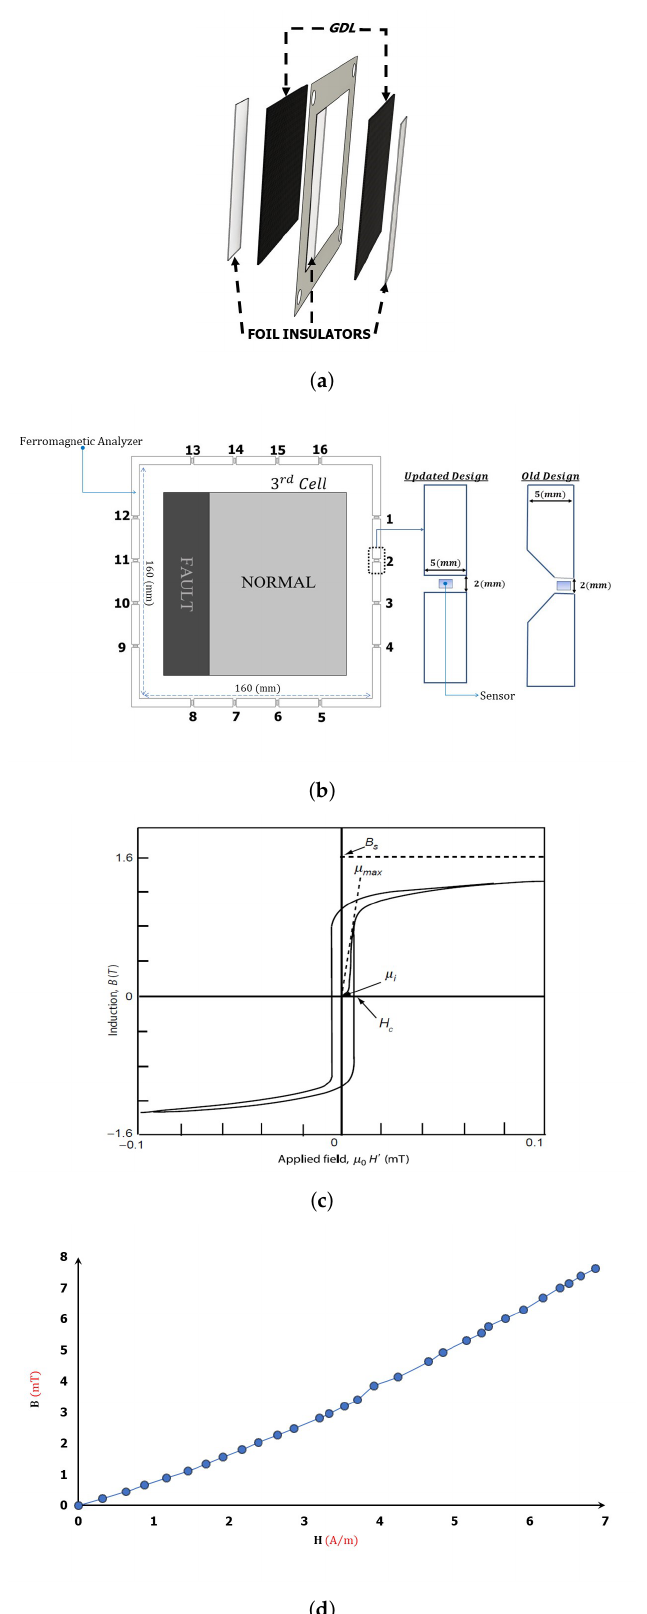
Figure 8. (a) Active area with the fault type, (b) circuit analyzer with sensors, (c) difference between Figure 8. ( a ) Active area with the fault type, ( b ) circuit analyzer with sensors, ( c ) difference between µ i and µ max for soft magnetic materials [59], and (d) characterization of the ferromagnetic material µ i and µ max for soft magnetic materials [59], and ( d ) characterization of the ferromagnetic material used in the analyzer. used in the